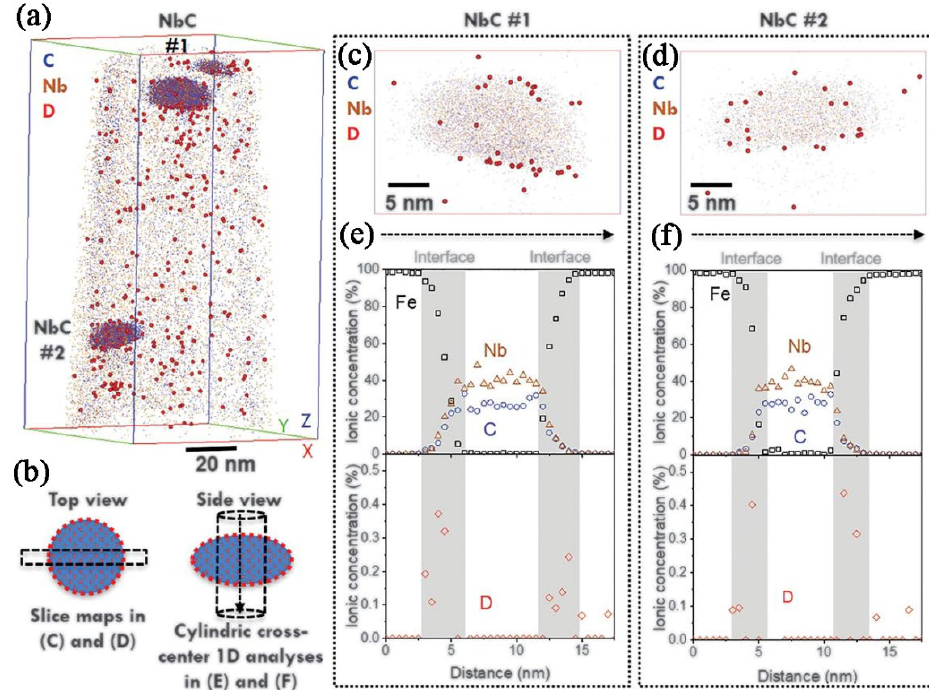
Figure 12. APT analysis of a D-charged ferritic steel sample containing NbC [95]. ( a ) Full recon- structed atom map showing atoms with mass-to-charge ratios that match D (large red spheres), C (small blue spheres), and niobium (Nb, small brown spheres). ( b ) Schematic describing the data in (C) to (F). ( c – f ) Local enlarged views of ( a ). Reprinted with permission from [95]. Copyright 2022